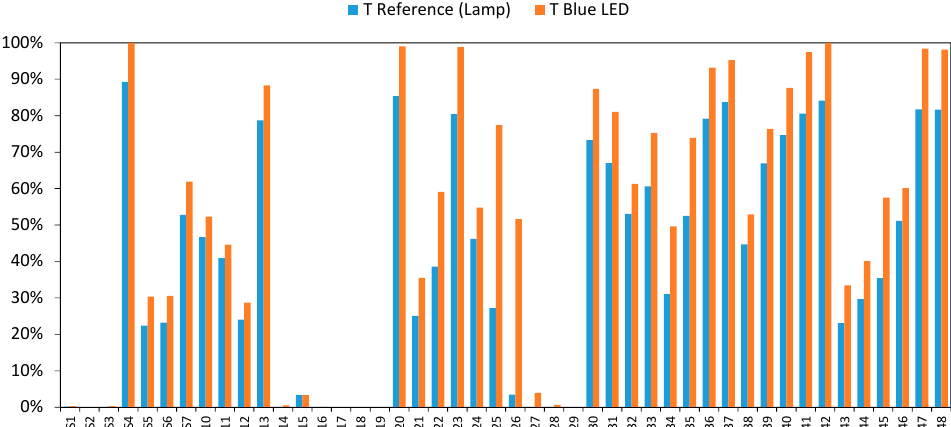
Figure 7. Comparative transmittance values by the blue LED and incandescent lamp at 460 nm.